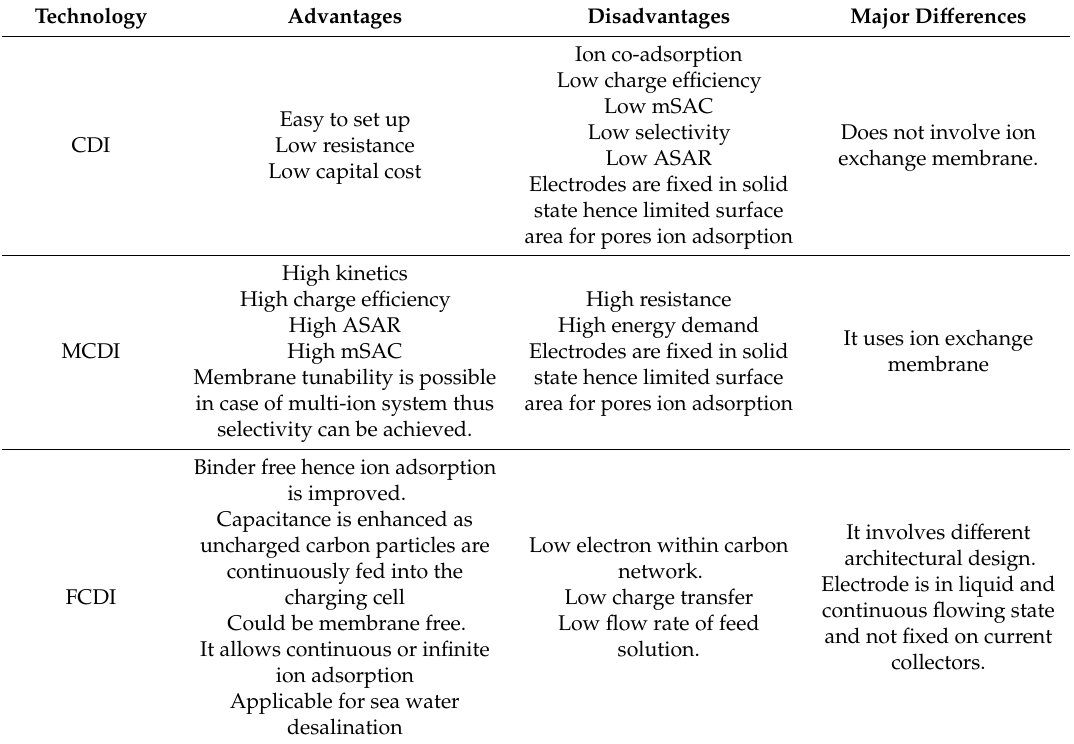
Table 6. Pros and cons with major di ff erences between CDI / MCDI /